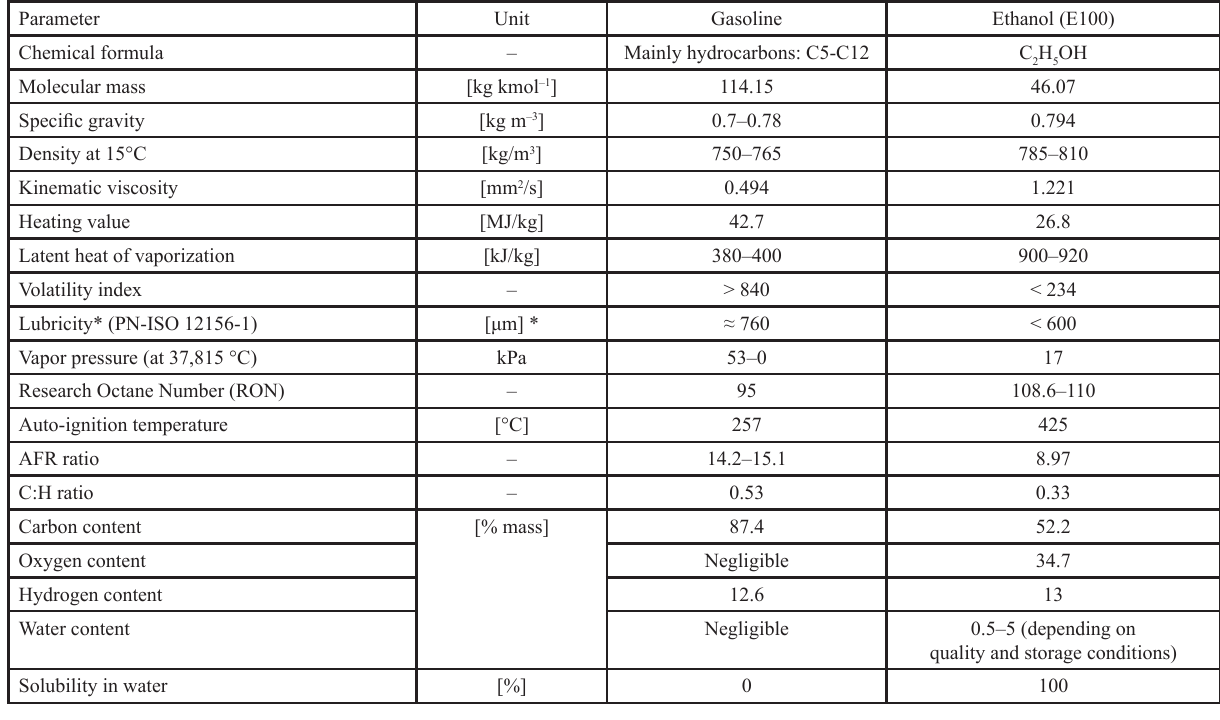
Fig. 2. A comparison of the ethanol molecule and compounds contained in standard gasoline Table 1. The physicochemical properties of ethanol and gasoline [7]